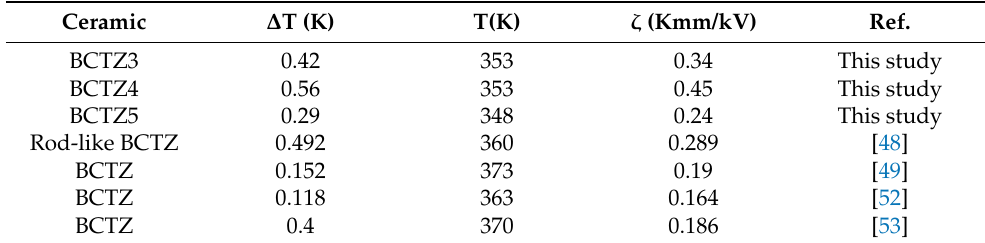
Table 2. Comparison of the electrocaloric properties of BCTZ with those of other Ba 0.85 Ca